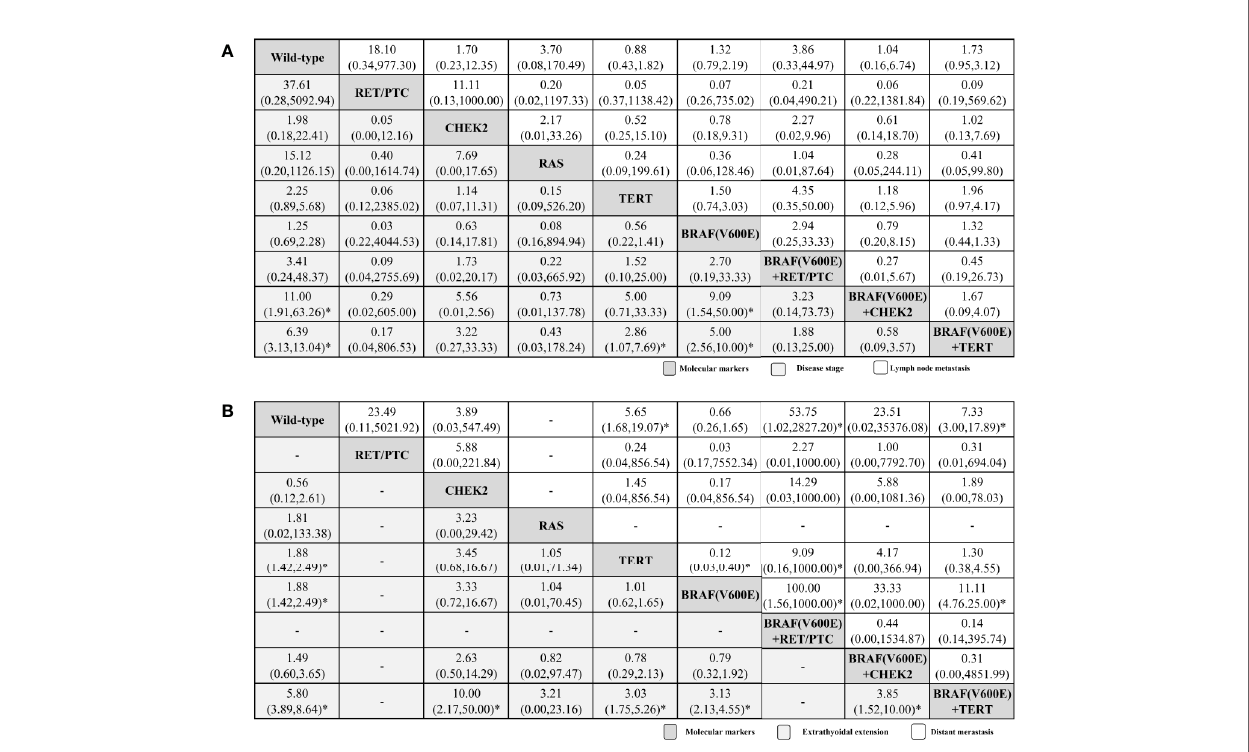
FIGURE 3 | Histopathological feature pro fi les for the disease stage and lymph node metastasis (A) , extrathyroidal extension, and distant metastasis (B) based PTC outcomes. From left to right, molecular markers for disease stage and lymph node metastasis (A) , extrathyroidal extension and distant metastasis (B) are ranked by mean rank and SUCRA score. Information relating to the ORs and 95% CrI is listed in the column, with the rows displaying molecular marker identity. OR values higher than 1 favor the column-de fi ning treatment (i.e., the left-most in order), indicating histopathological features associated with a worse prognosis. To obtain OR values for comparisons in the opposite direction, reciprocals should be taken. *Statistical signi fi